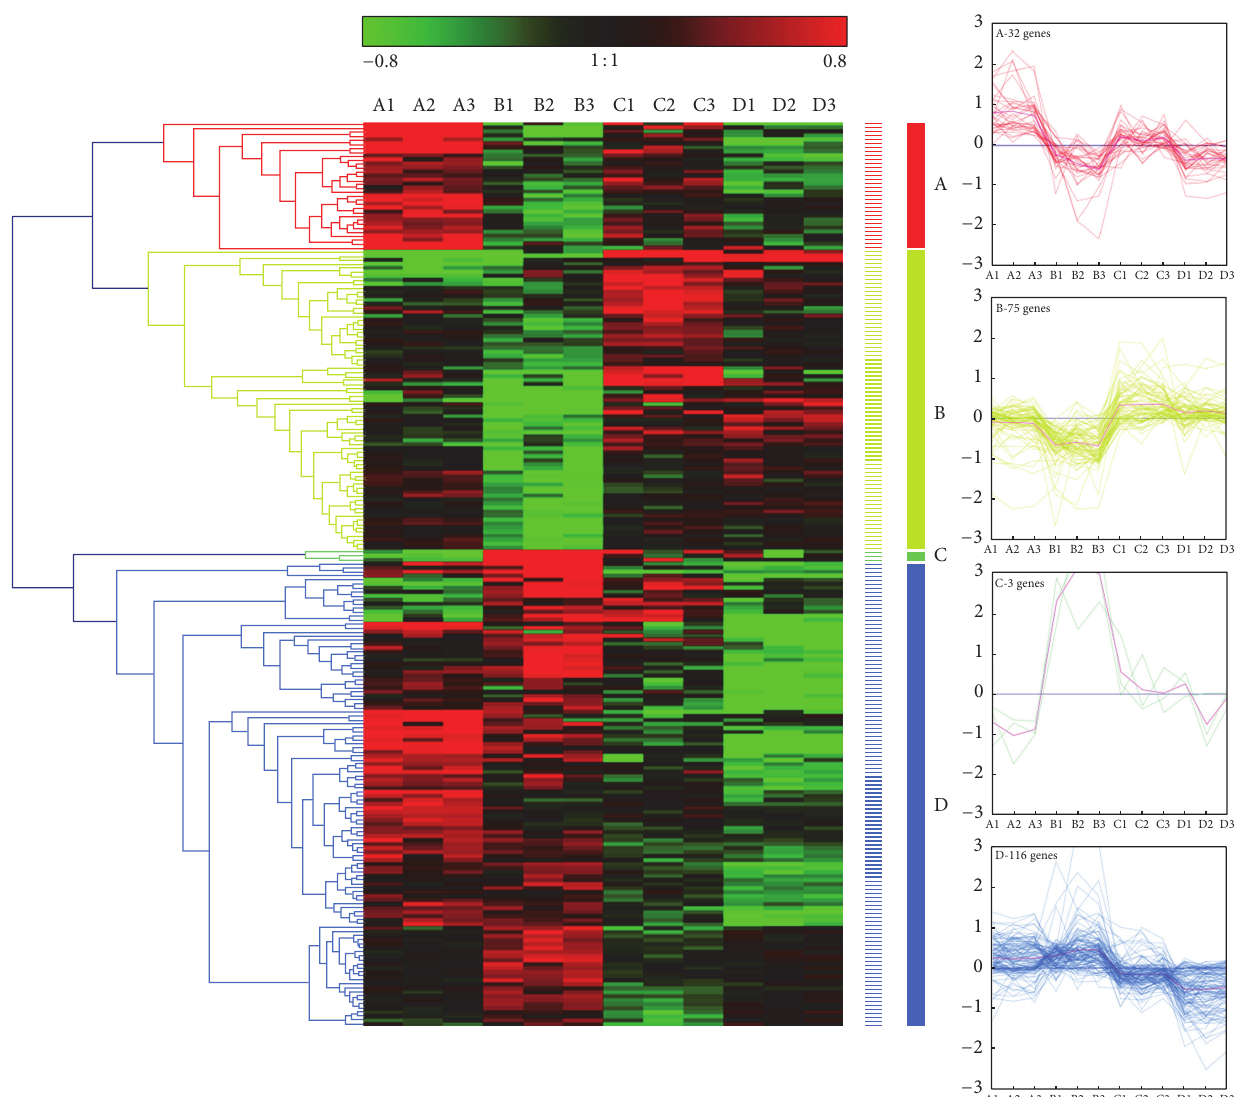
Figure 6: Cluster analysis of the expression profiles. Cluster analysis of the expression profiles of 226 genes in the highly significantly enriched GO terms. Cluster analysis for each group of genes was performed using hierarchical clustering with Genesis 1.7.5 with average linkage and Euclidian distance measurements. Rows represent differentially expressed genes, while columns represent different independent treatments (A, B, C, and D represent the germinated seeds treated with 0 (pH 6.0), 0 (pH 4.5), 0.8 (pH 4.5), and 3.2 (pH 4.5) mM AlCl 3 solution for 60 h, resp.; each treatment was repeated three times). The color scale shown at the top illustrates the relative expression ratios of genes across all samples. Four line charts of the four groups are shown on the